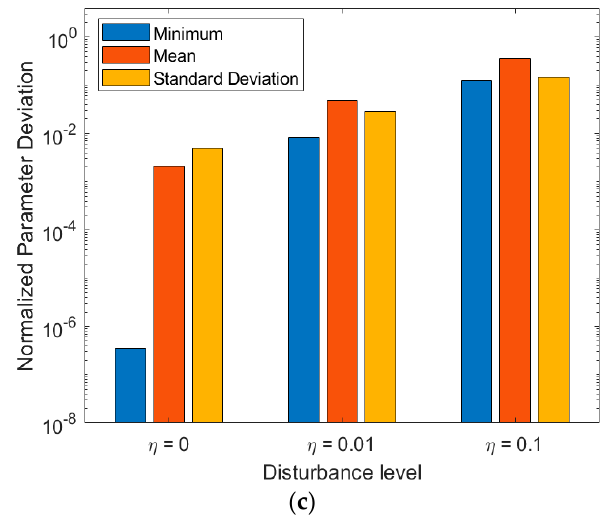
Figure 8. Graphic interpretation of statistics for different evaluation metrics in the case of Problem 1. ( a ) MSE through estimated responses ( b ) MSE through estimated parameters ( c ) Normalized parameter deviation. Table 1. Results of statistical indices for different evaluation metrics in Problem 1.